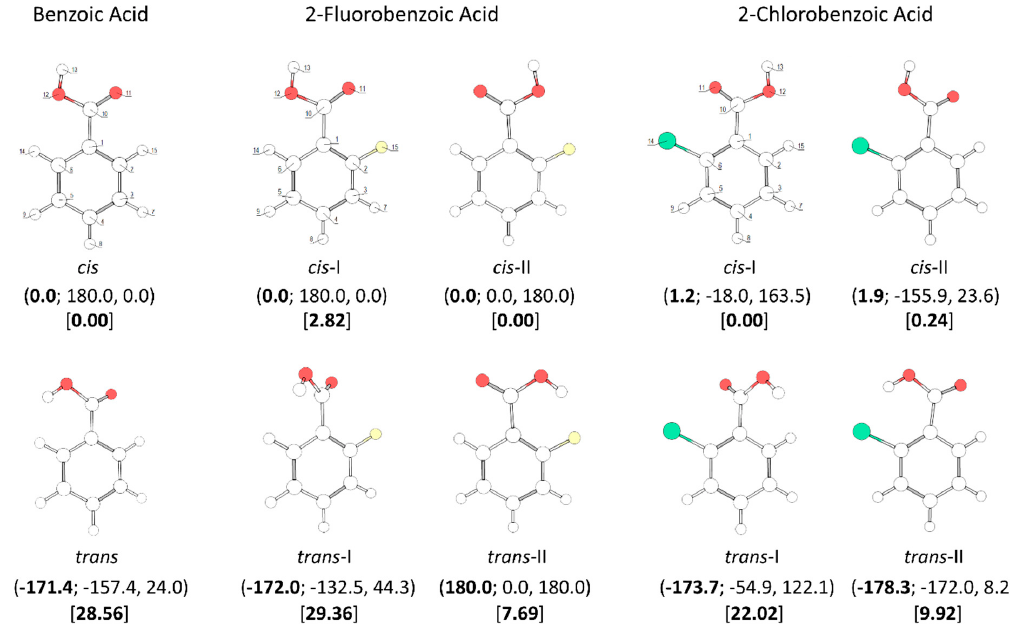
Figure 1. B3LYP / 6-311 ++ G(d,p) calculated minimum energy structures of benzoic acid, 2-fluorobenzoic acid and 2-chlorobenzoic acid, with adopted atom numbering. The values of the O = C-O-H, C6-C-C = O and C2-C-C = O dihedral angles (in o ) are given in parentheses by this order (the first using bold style). Relative energies are given in square parentheses (in bold), in kJ · mol − 1 . Each depicted non-planar structure has a symmetry-related form. The cis benzoic acid conformer is also two-fold degenerate, while the trans conformer 4-fold symmetry degenerate.